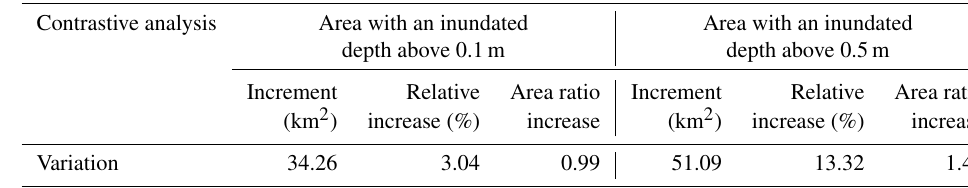
Table 4. Increment of the waterlogging area in the lakeside area of NL.